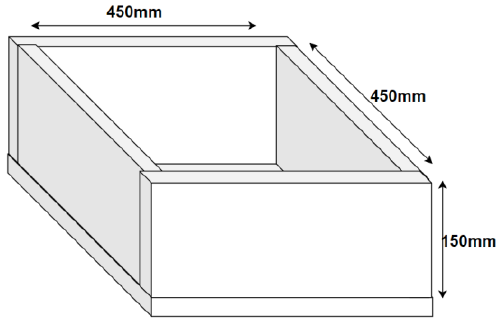
Figure 3. Schematic of complete box frame with inner dimension of 150 mm × 450 mm × 450 mm.